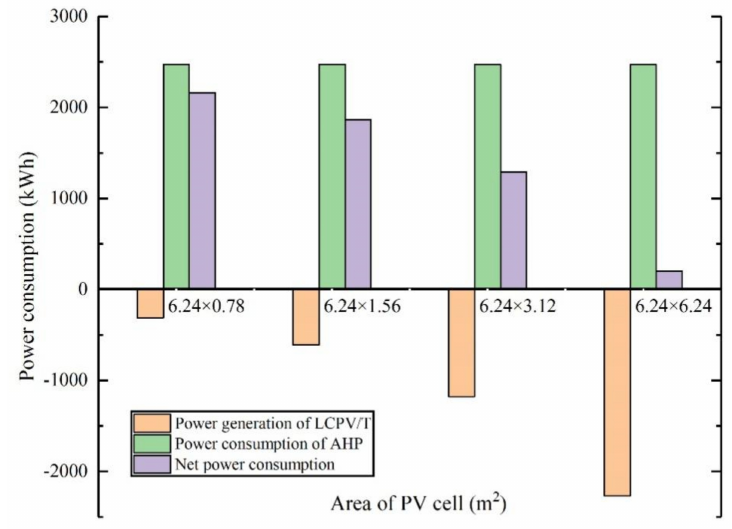
Figure 27. Power generation of the LCPV/T and consumption of the AHP under different PV cell